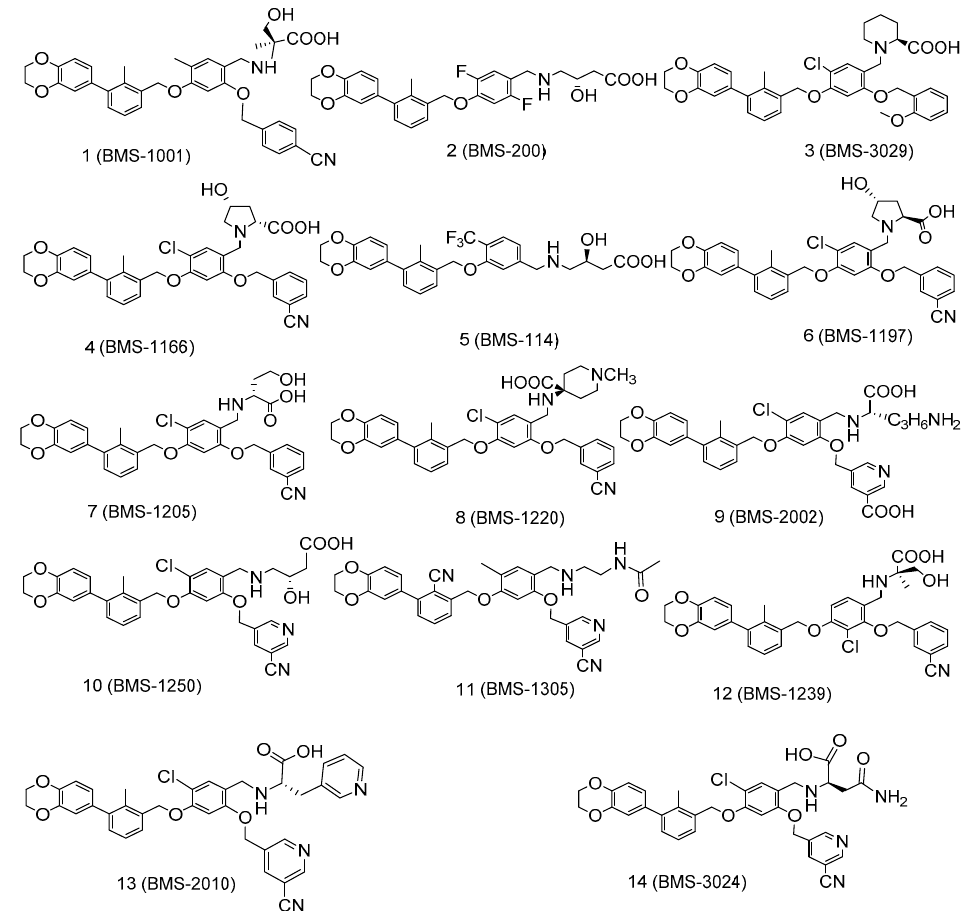
Figure 1. Structures of the programmed cell death protein 1 (PD-1)/programmed cell death ligand 1 (PD-L1) complex inhibitors (1–14) used in docking studies. Int. J. Mol. Sci. 2019 , 20 , x FOR PEER REVIEW